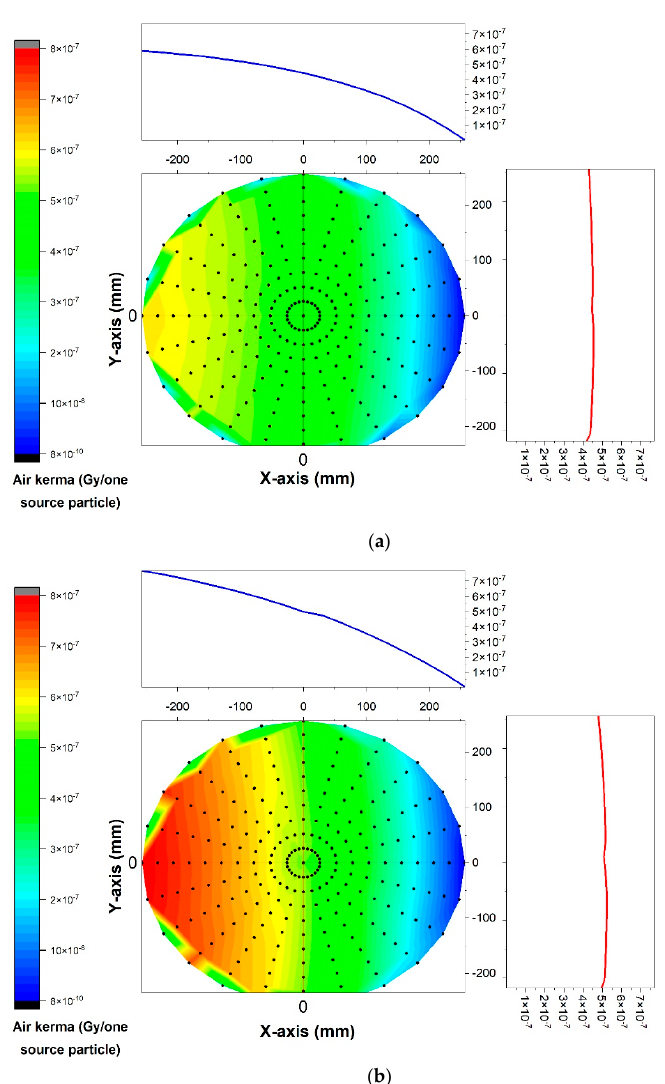
Figure 2. Calculated air kerma within X-ray beam’s field of view of modeled X-ray tube by Monte Carlo simulation for point detectors placed at a certain distance (75 mm) from source of two different tube voltages: ( a ) 60 kV and ( b ) 120 kV.